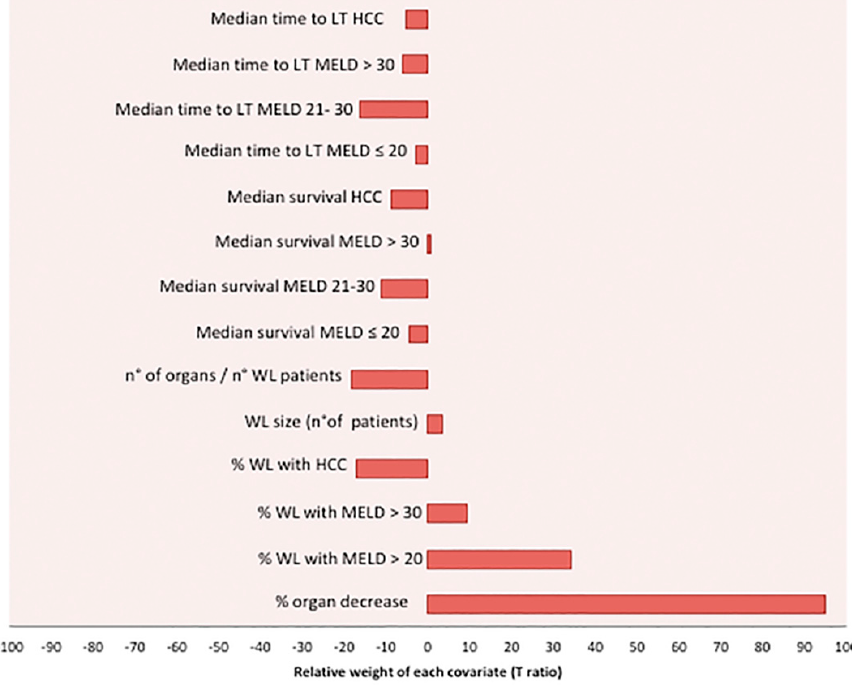
Figure 3. Multivariate analysis on the 10,000 outcome results of the Monte Carlo simulation. The relative contribution of each covariate to the harm to others on the WL was measured by the T ratio value of each covariate distribution introduced in the Monte Carlo